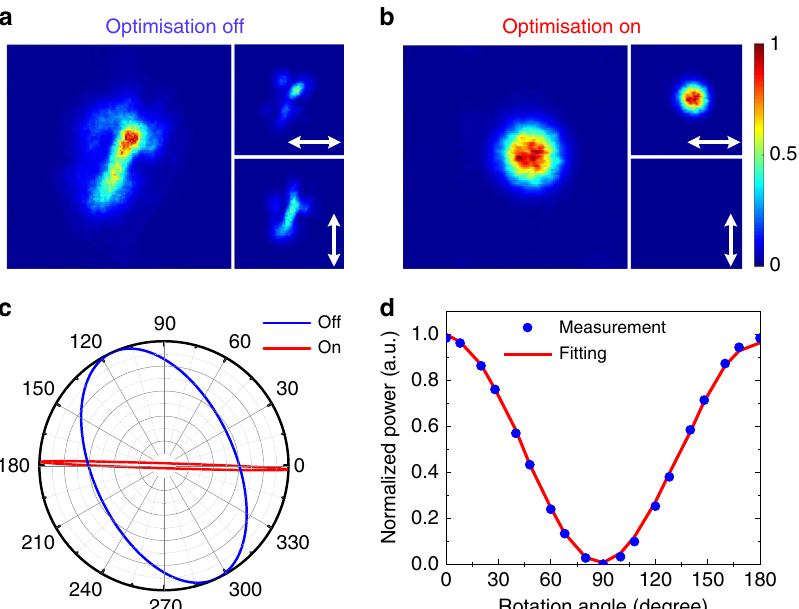
Fig. 3 Experimental demonstrations of depolarization and phase mismatch in a MCF ampli fi er and the requirement for active input control to generate a linearly polarized Gaussian beam. a When optimisation is off (without any wavefront and polarization shaping for the beamlet input signals), the measured far- fi eld intensity and the two orthogonal polarization components after passing the combined beam through a linear polarizer (white arrows show the transmission axes of the linear polarizer). Signi fi cant depolarization and phase mismatch were observed after ampli fi cation through the MCF ampli fi er. b After optimisation of the wavefront and polarization state of the input signal (i.e. Optimisation ON), the measured far- fi eld intensity and the horizontal and vertical polarization components of the output beam. In this case, a well-de fi ned linearly polarized Gaussian beam was obtained. c, The measured polarization ellipses for the output beams of a , b showing that the initial elliptical polarization was ef fi ciently converted to the desired linear polarization under active control. d The output power measured by rotating a linear polarizer in the case of active control. The angular dependency is again well described by a cosine squared fi t and the measured PER was ∼ 15 dB.